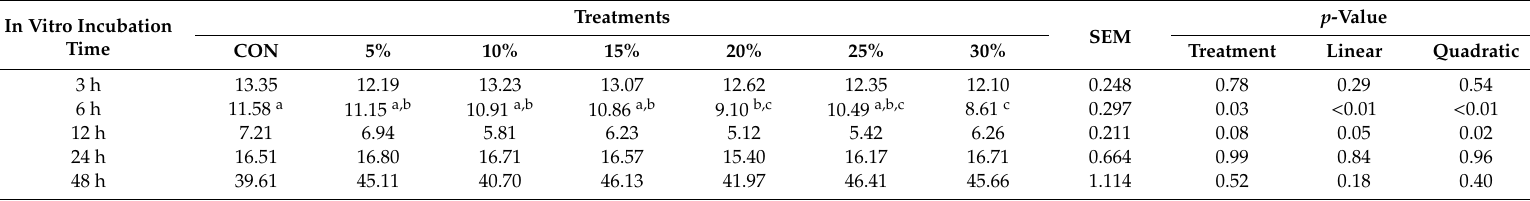
Table 5. E ff ects of di ff erent cassava residue substitution ratio for crushed maize on in vitro NH 3 –N content in dairy cows at mid-lactation (mg / dL) 1 . In Vitro Incubation Time